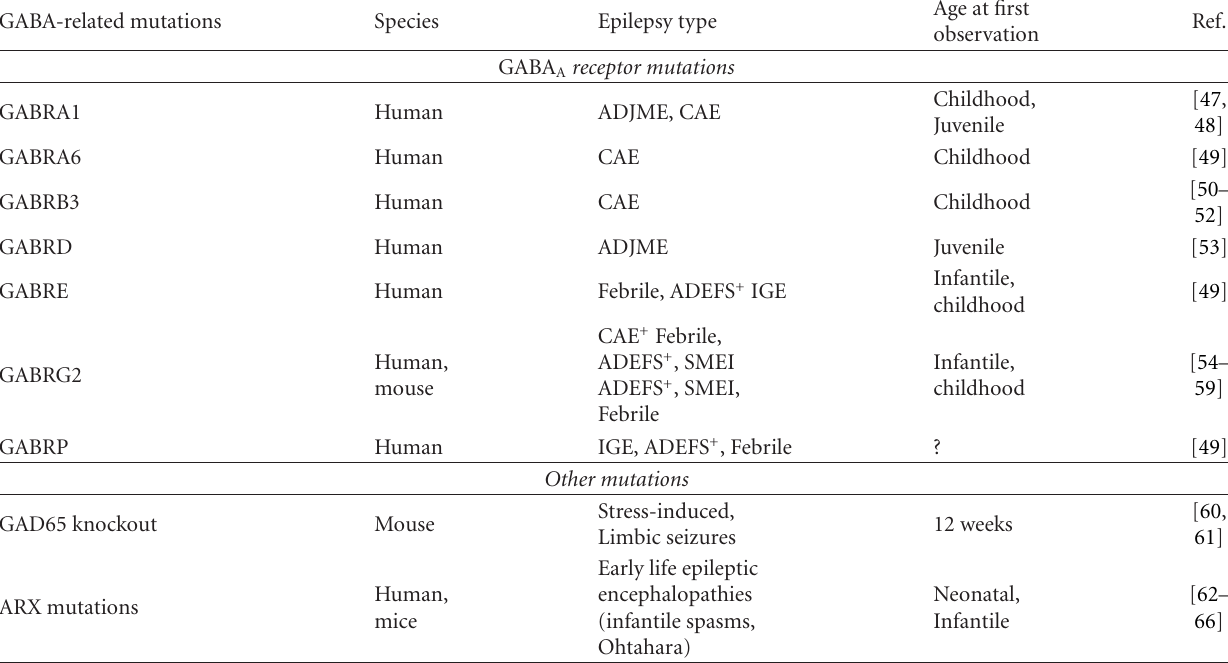
Table 1: GABA-related mutations linked with